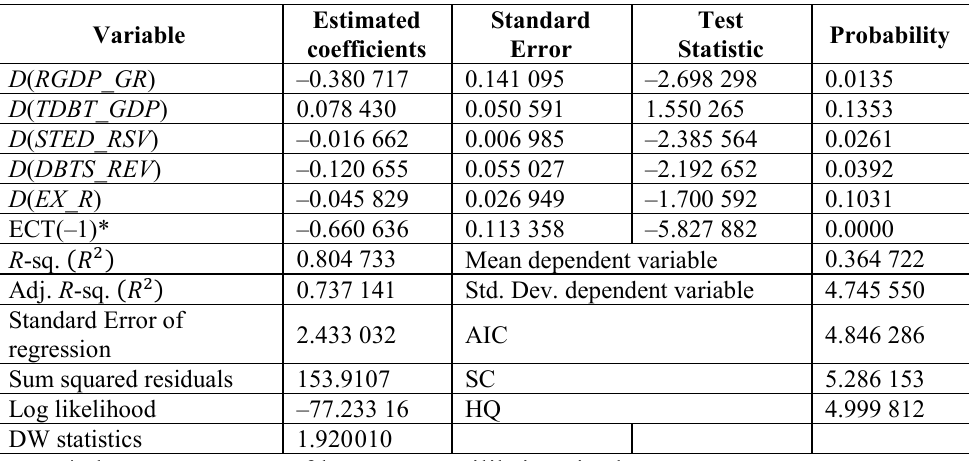
Table 5. ECM (The authors’ computation, 2021)